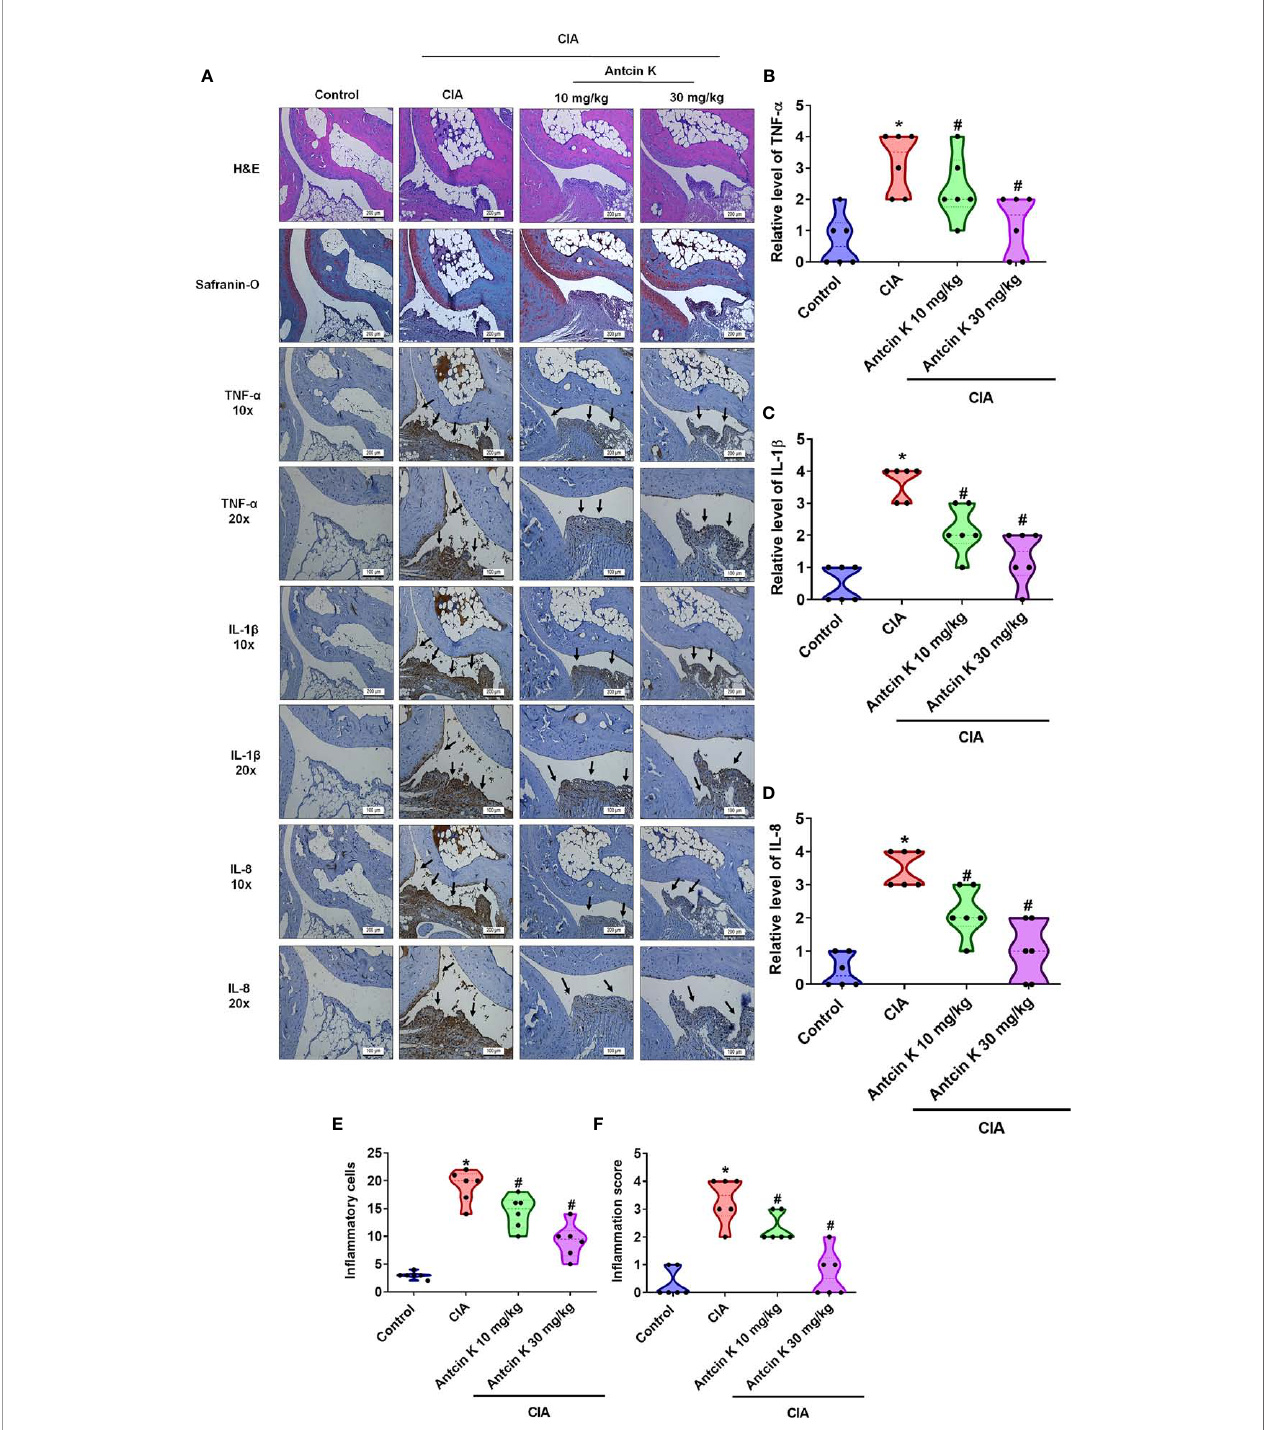
FIGURE 8 | Effects of Antcin K quanti fi ed by histopathological changes in ankle joints from CIA mice. (A) Representative magni fi ed images of histologic sections taken from ankle joints that were stained with H&E and Safranin-O, and IHC staining for TNF- a , IL-1 b and IL-8 antibodies from healthy controls, untreated CIA mice, and CIA mice administered Antcin K 10 mg/kg or 30 mg/kg (N=6 per group). (B – D) Quanti fi cation of TNF- a , IL-1 b and IL-8 expression by IHC score. (E, F) Quanti fi cation of in fl ammation scores and pathology fi ndings in ankle joint synovium and adjacent tissue (details are provided in Supplementary Table 1 ). Results are expressed as the mean ± SD. *P < 0.05 compared with controls; # P < 0.05 compared with the untreated CIA